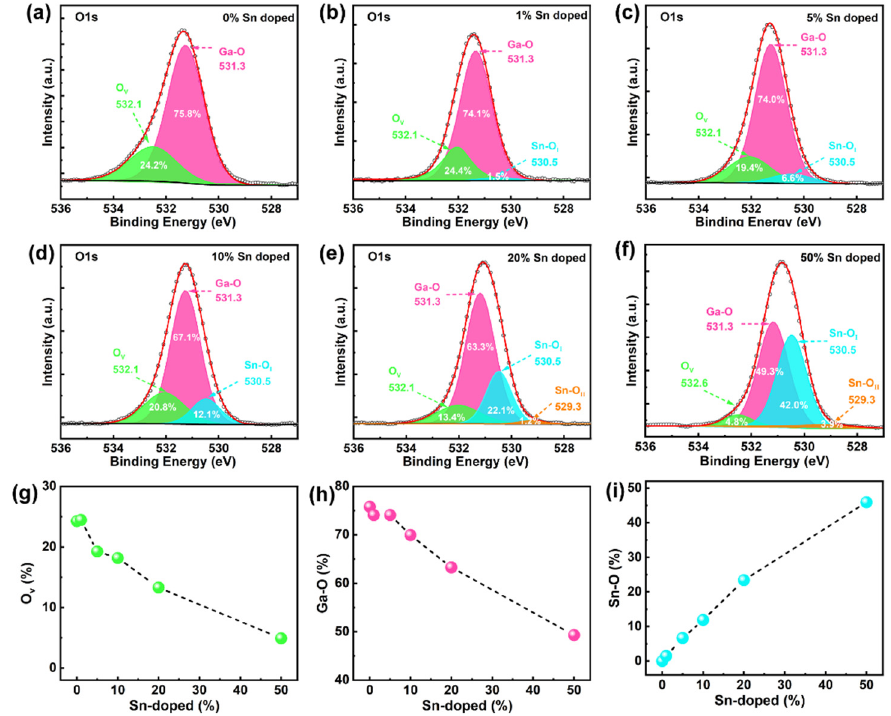
Figure 3. ( a – f ) XPS analysis of the O 1s peak of the Ga 2 O 3 thin films for different concentrations of Sn. Graphs depicting the percent of ( g ) O v , ( h ) Ga–O, and ( i ) Sn–O bonds for various Sn concentra ‐ tions.